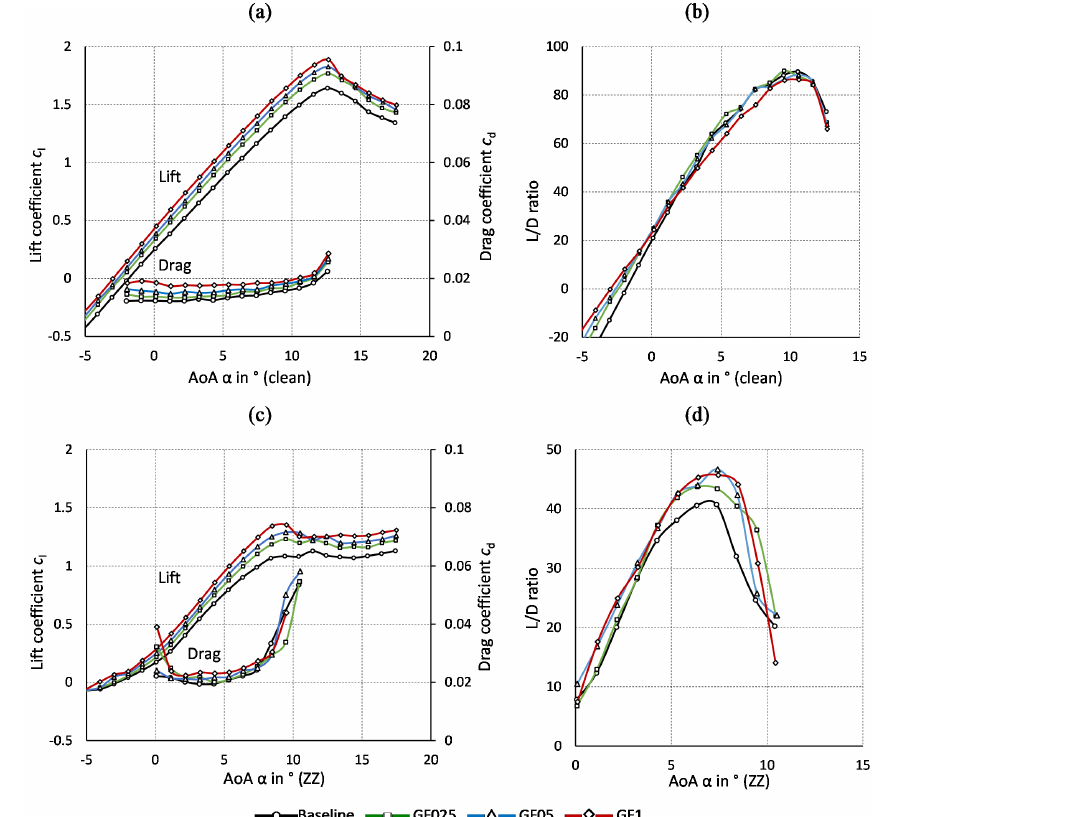
Figure C2. DU97W300. Gurney flaps. (a) Lift and drag coefficients (clean). (b) L/D ratio (clean). (c) Lift and drag coefficients (ZZ). (d) L/D ratio